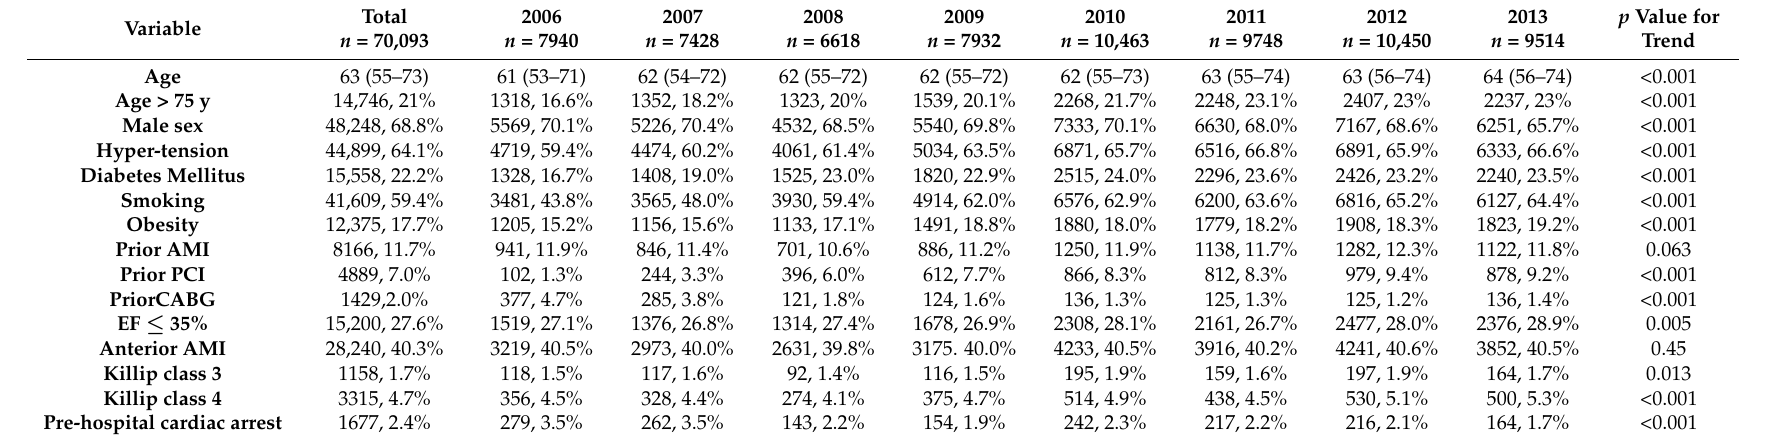
Table 1. Temporal trends in risk factors, clinical history and clinical presentation 2006–2013.